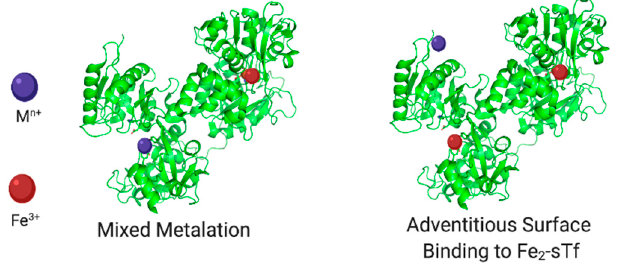
Figure 14. Fe(III)-bound sTf modes for nonferric metal ion cellular uptake. Created with BioRender.com.